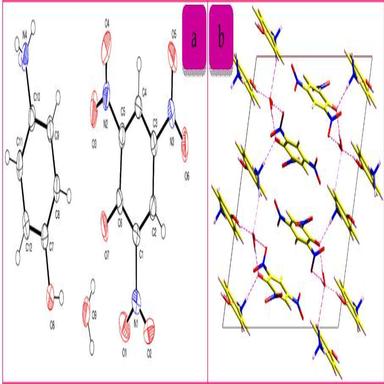
a) ORTEP and (b) Packing diagram of HAPH